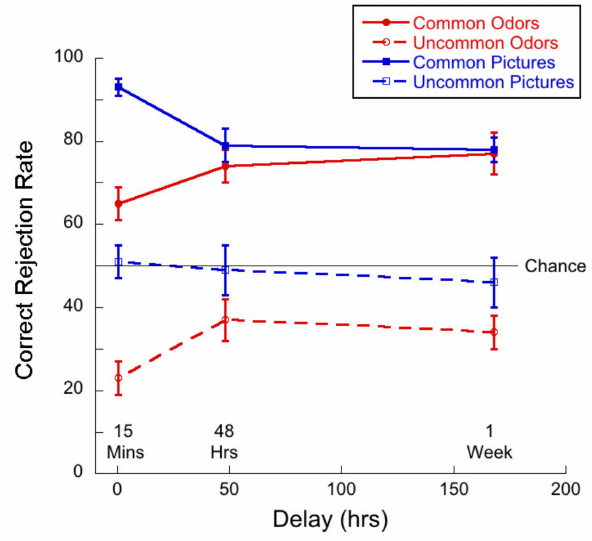
Figure 12. Correct rejection rate as a function of delay for each of the four test conditions. Given that this was a “monadic” task, guessing would result in a hit rate of